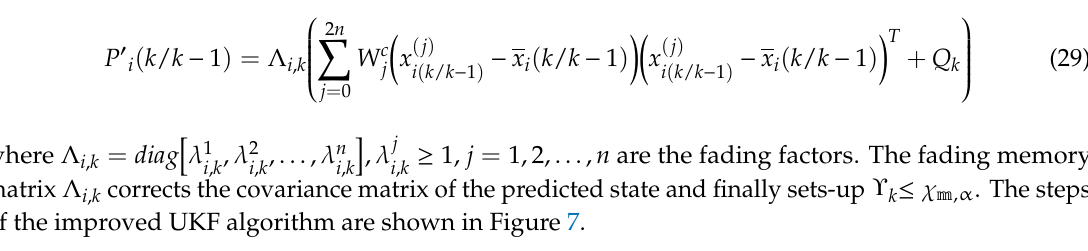
Figure 7. Procedure of improved unscented Kalman filtering. 3.1.3. Embedding of Sequential Measurement Fusion In this section, we design a reasonable local fusion estimator for the second stage sensor in each cluster (inside the oxidation tank). After filtering the original temperature data using the underlying sensor in the first stage, the idea of sequential measurement fusion is embedded into the measurement update link after the UT in the improved UKF, and the measurements sent in time series are fused. Local measurement estimates are then generated. Sequential analysis was first proposed by Abraham Wolde in 1940 as a method to test statistical hypotheses and continuously analyze statistical data on the premise that they are available [33]. After that, it was widely used in the field of signal detection. As asynchronous transmission often occurs in sensor networks, the traditional batch processing fusion algorithm does not provide advantages in computational complexity and running time, whereas the sequential fusion method carries out